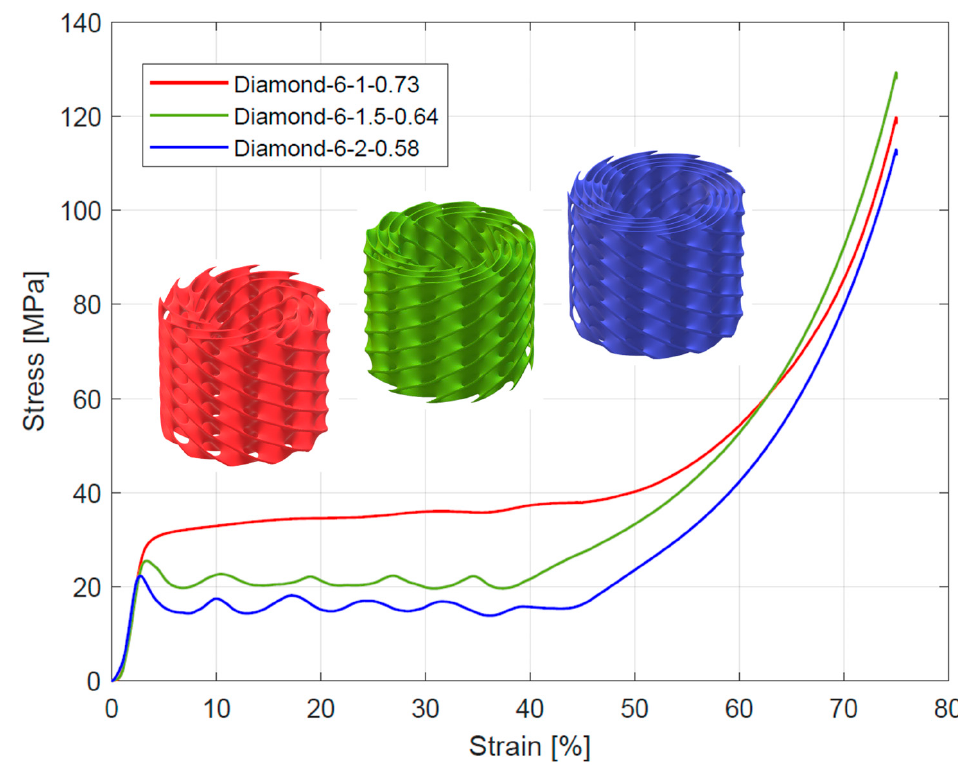
Figure 6. Stress–strain curves from compressive testing of Diamond TPMS cylindrical structures with 6 unit cells in a circumferential direction.